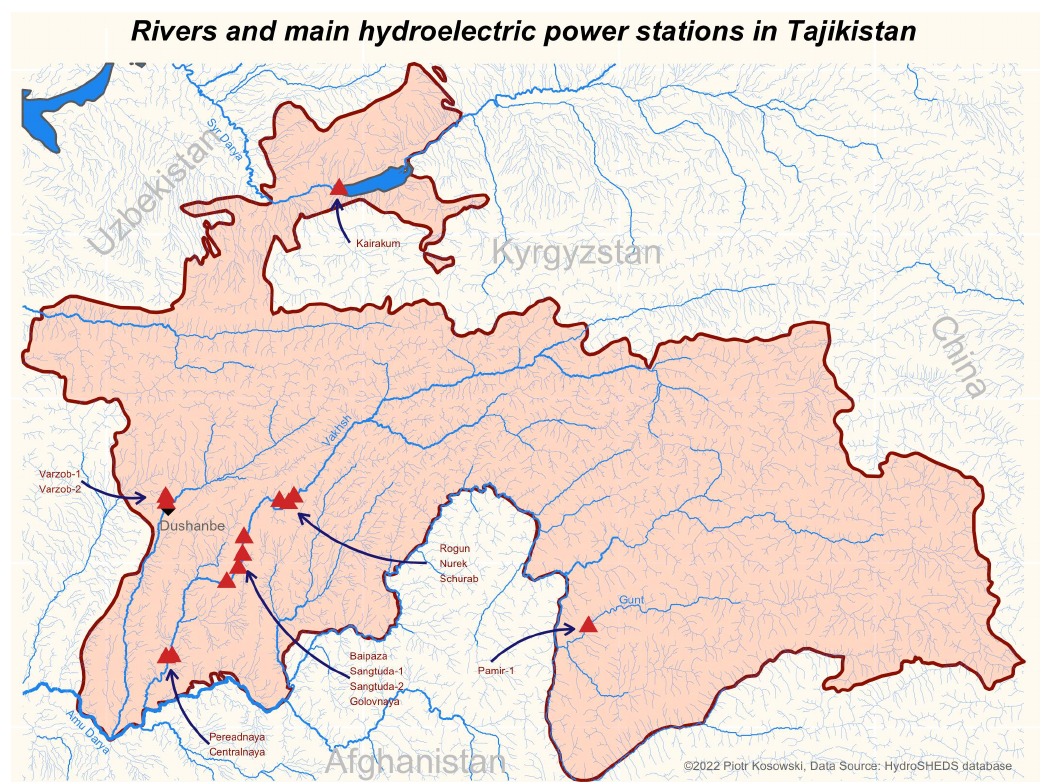
Figure 5. Rivers and main hydroelectric power stations in Tajikistan.